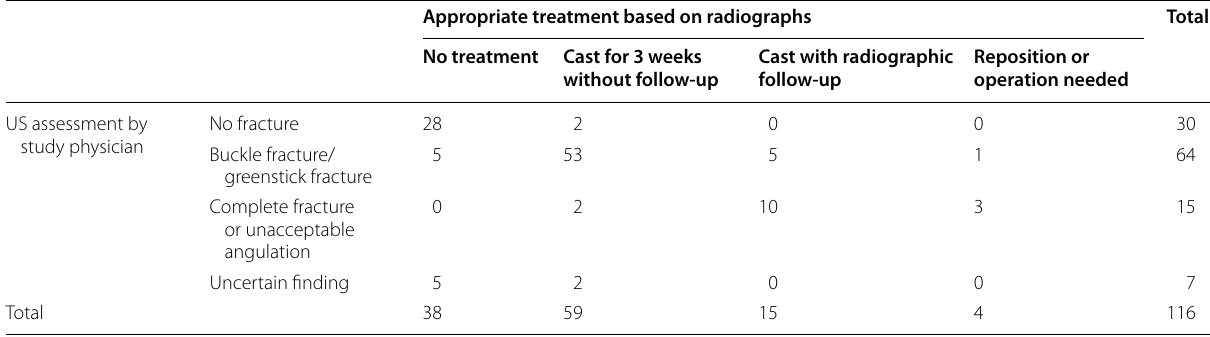
Table 3 The study physician’s interpretation of the US examination at the ED cross-tabulated with the gold standard treatment decided by senior traumatologists based on